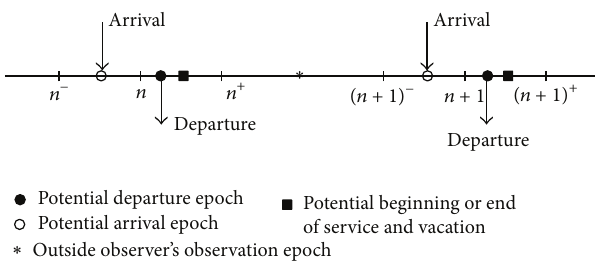
Figure 1: Various time epochs in a late arrival system with delayed access